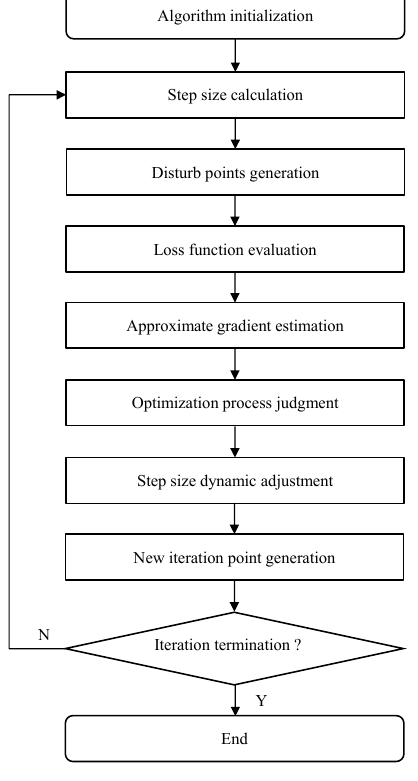
Figure 7. Flowchart of the IK − SPSA.